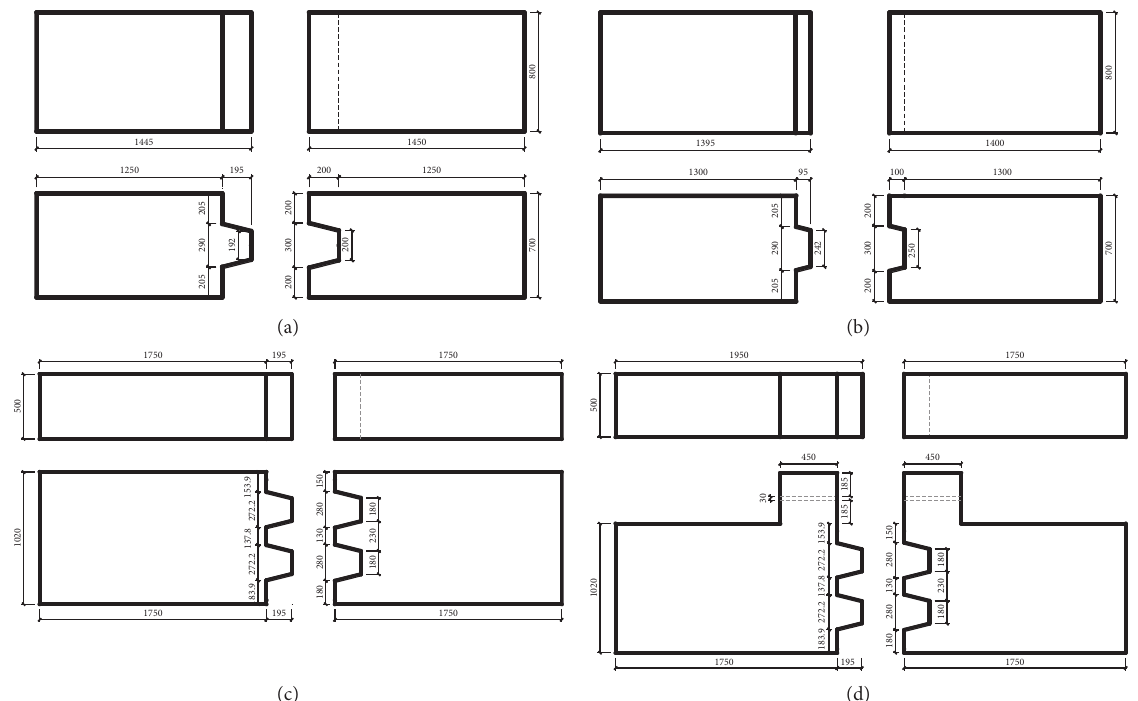
Figure 3: Specimen size of grouted mortise-tenon joint. (a) Long single-tenon joint, (b) Short single-tenon joint, (c) Double-tenon joint, (d) Double-tenon joint with auxiliary pretightening device.